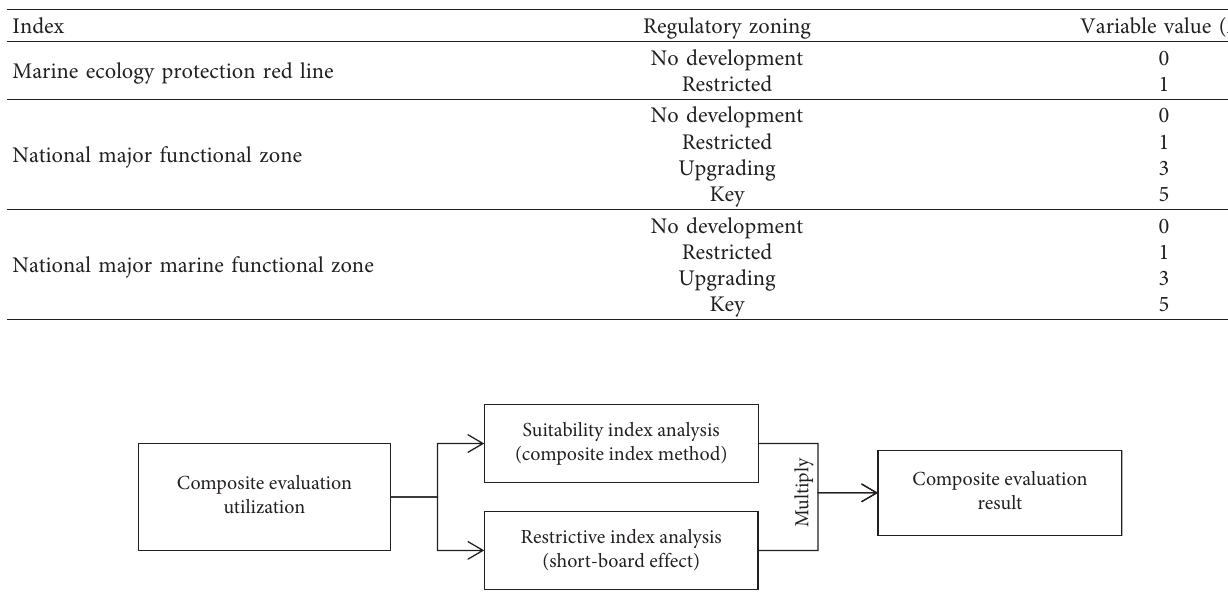
Table 2: Restrictive index classification and variable values.